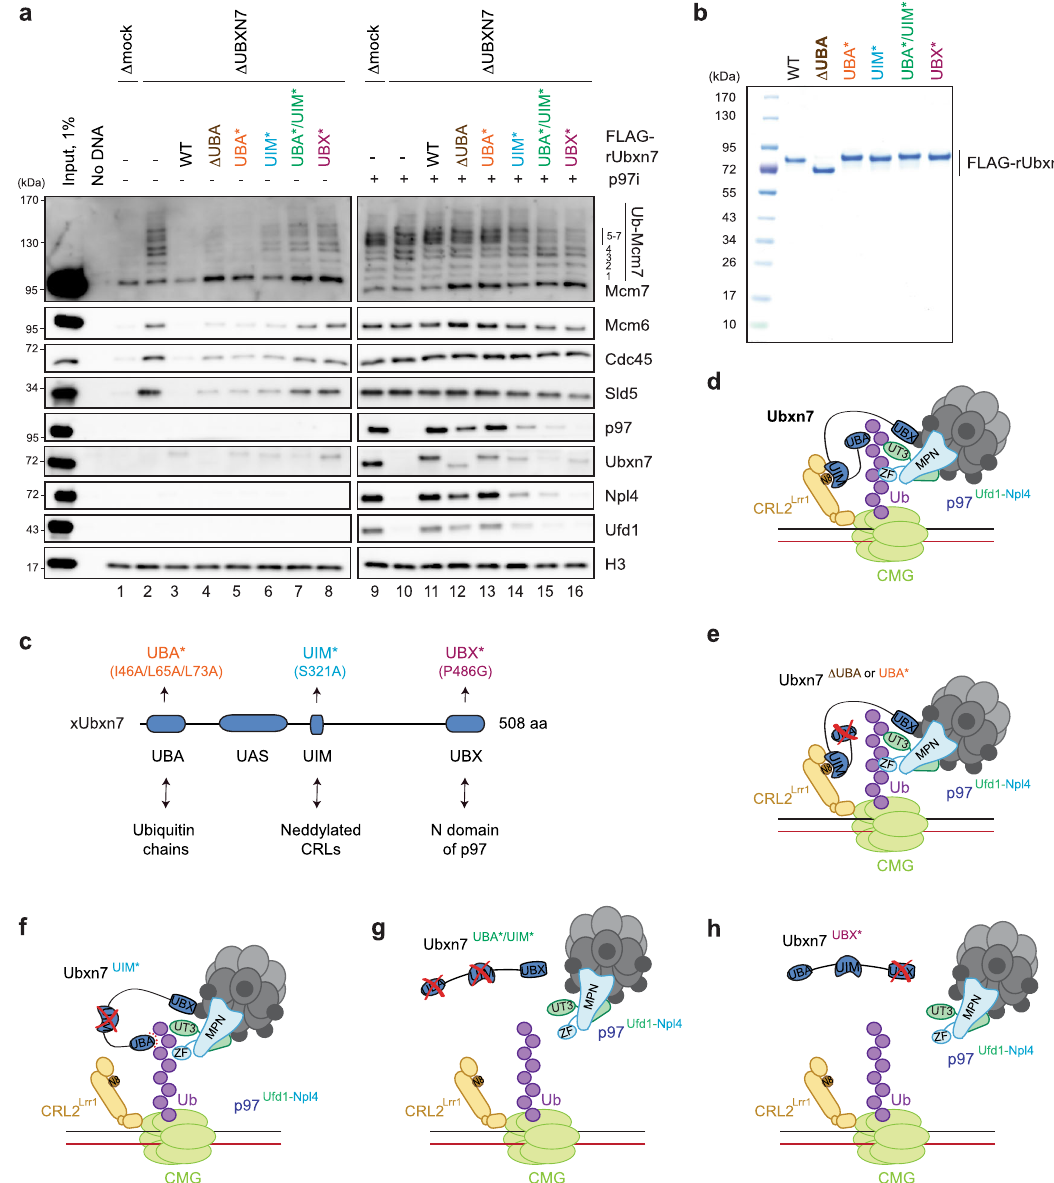
Fig. 1 | Ubxn7 promotes unloading ofterminated CMG in interphase. a Analysis of chromatin-bound proteins in mock- or Ubxn7-depleted extracts in the absence or presence of p97i.Plasmid wasincubated in totalegg lysate tocarryoutlicensing,and then exposed to nucleoplasmic extract (NPE) to initiate replication. Extracts were supplemented with rUbxn7 variants as indicated. At 20min after NPE addition, plas- mids were recovered with LacR-coated beads and immunoblotted for the indicated proteins. Ub-Mcm7, ubiquitylated Mcm7; Ubxn7 Δ UBA , deletion of the 1-74 N-terminal aminoacidsofUbxn7;Ubxn7 UBA* ,I46A/L65A/L73AaminoacidsubstitutionsintheUBA domain; Ubxn7 UIM* , S321A amino acid substitution in the UIM domain; Ubxn7 UBA*/UIM* ,